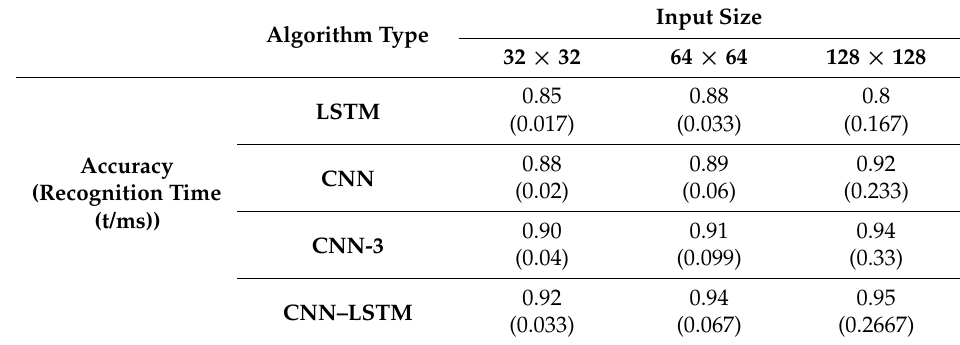
Table 1. The recognition accuracy and recognition time of different algorithms under different input